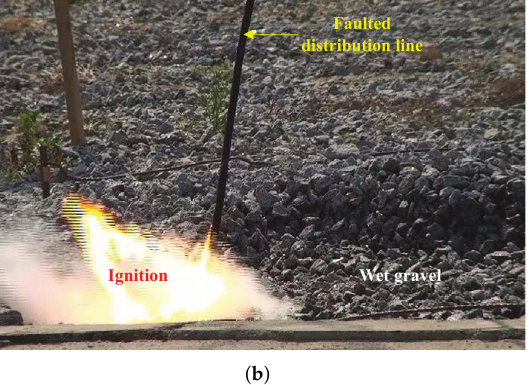
Figure 2. Experimental setup for arc generation. ( a ) Experiment environment. ( b ) Arc generation.